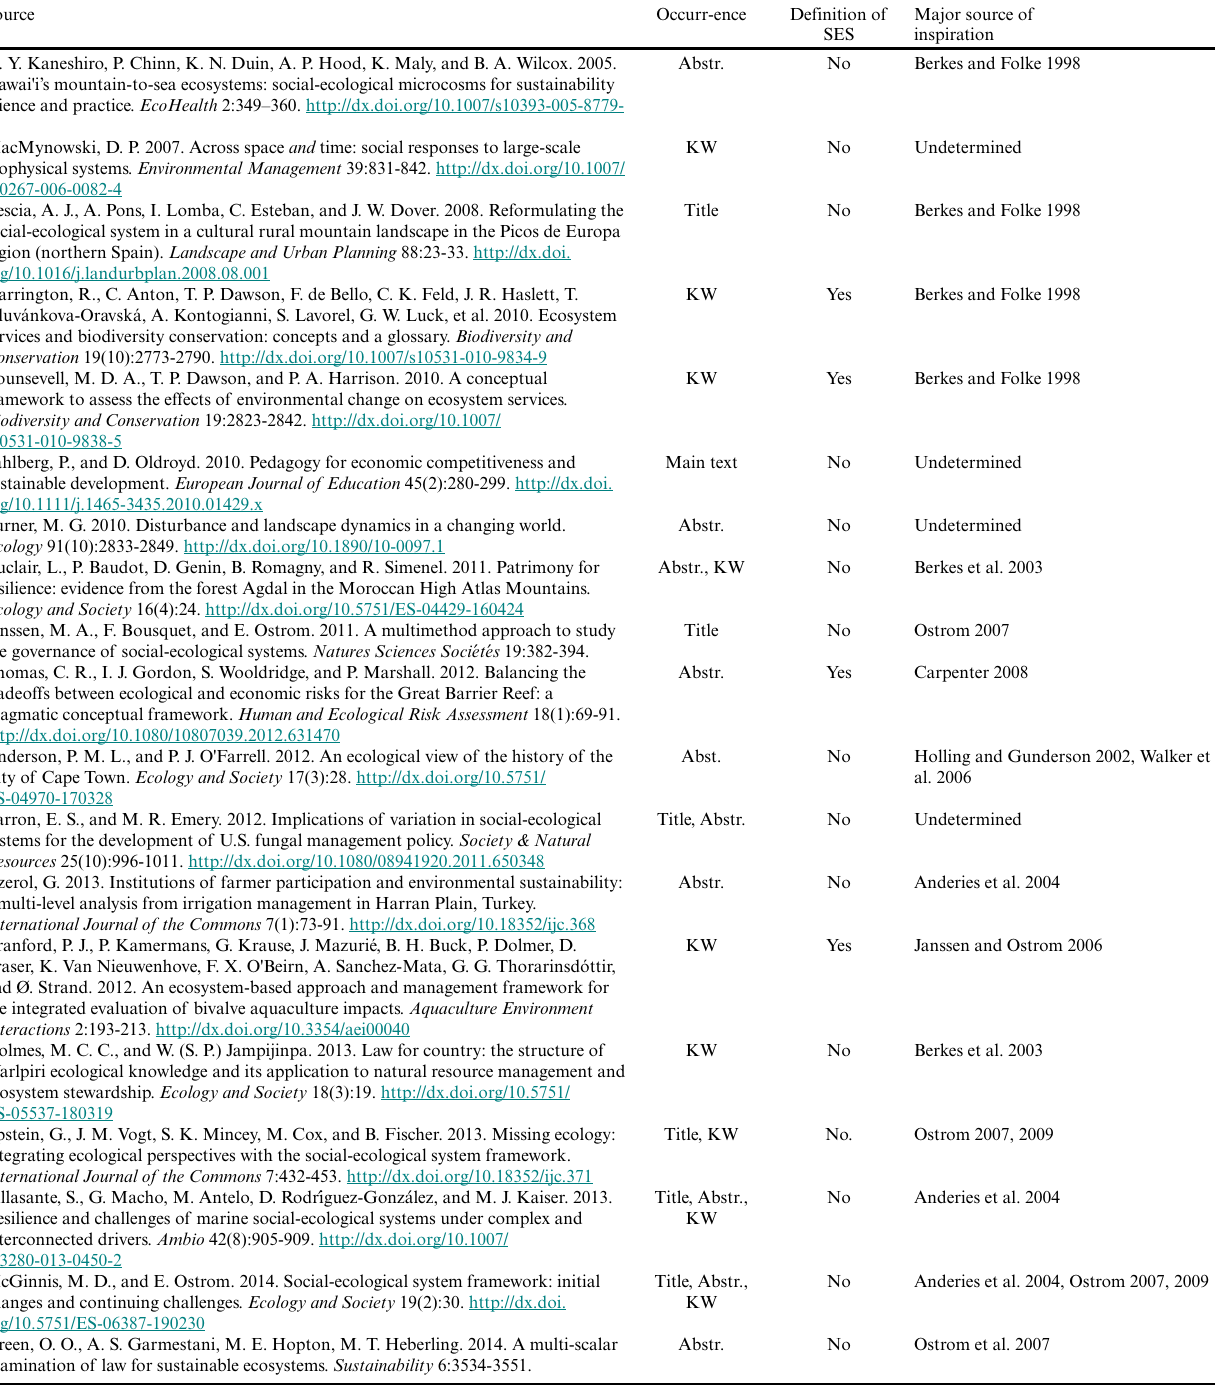
Table 1 . Fifty randomly selected publications for analysis of articles (T = 1598) dealing with social-ecological systems (SESs) from 1998 to 2017, based on abstract (Abstr.), keyword (KW), title, and limited to articles. Information retrieved on 20 August 2017 from the Scopus database. Source of inspiration denotes to key document(s) as referred to by author in relation to